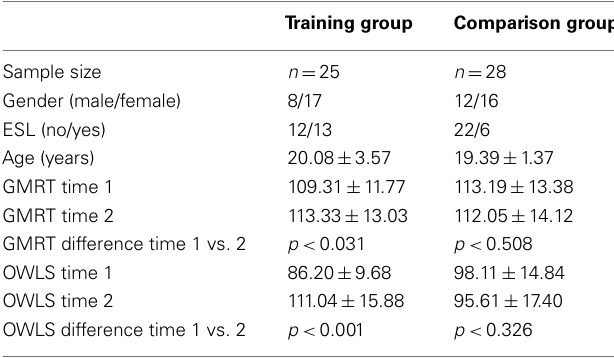
Table 1 | Demographic characteristics and standardized literacy measures by participant group.